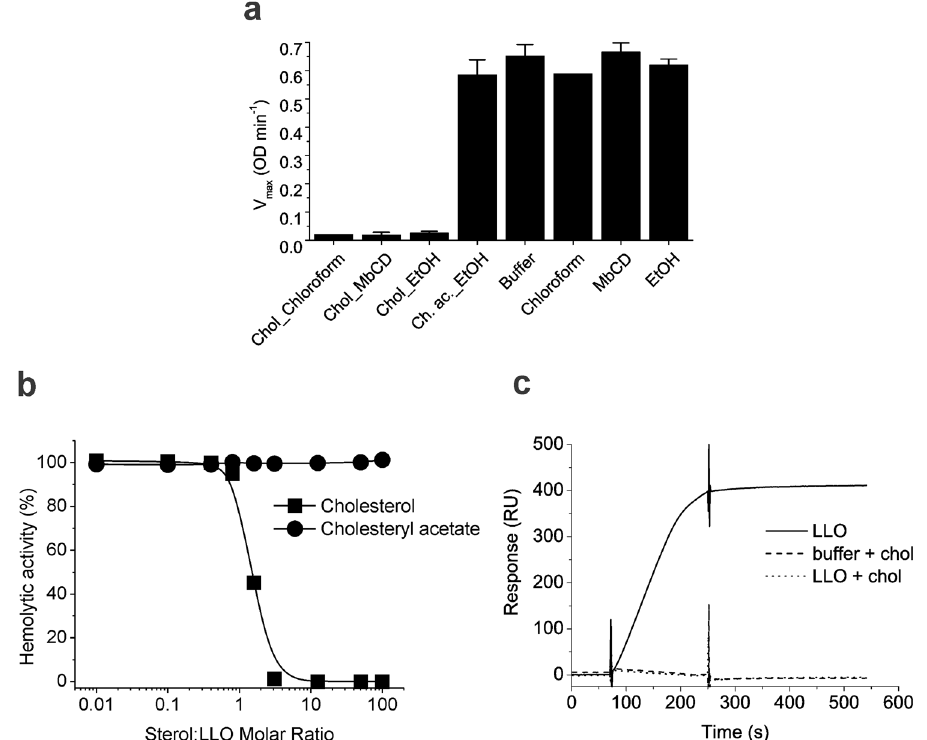
Figure 4. Interaction of LLO with various Chol preparations in solution. ( a ) Hemolysis maximal rate (OD min − 1 ) of 22 nM LLO in the presence of various solutions as indicated in the panel. n = 3, average ± S.D. EtOH, ethanol; Ch. ac., cholesteryl acetate; MbCD, M β CD. ( b ) Hemolytic activity of 3.6 nM LLO after 30 min incubation in the presence of different concentrations of Chol and cholesteryl acetate in ethanol solutions. n = 3, average ± S.D., and ( c ) SPR analysis of LLO binding to lipid membranes composed of POPC:Chol (6:4) lipid vesicles after 20 min incubation with Chol in ethanol at 10:1 molar ratio (Chol:LLO) compared to non-treated LLO and buffer with